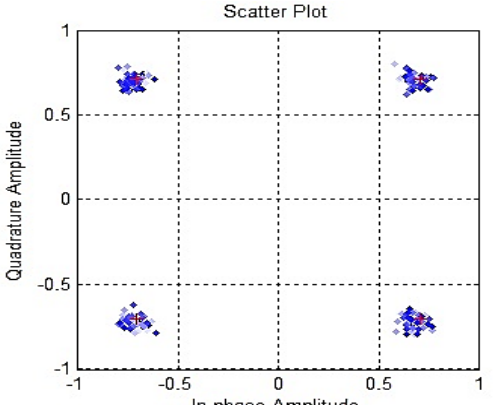
Figure 5: QPSK constellation for Proposed